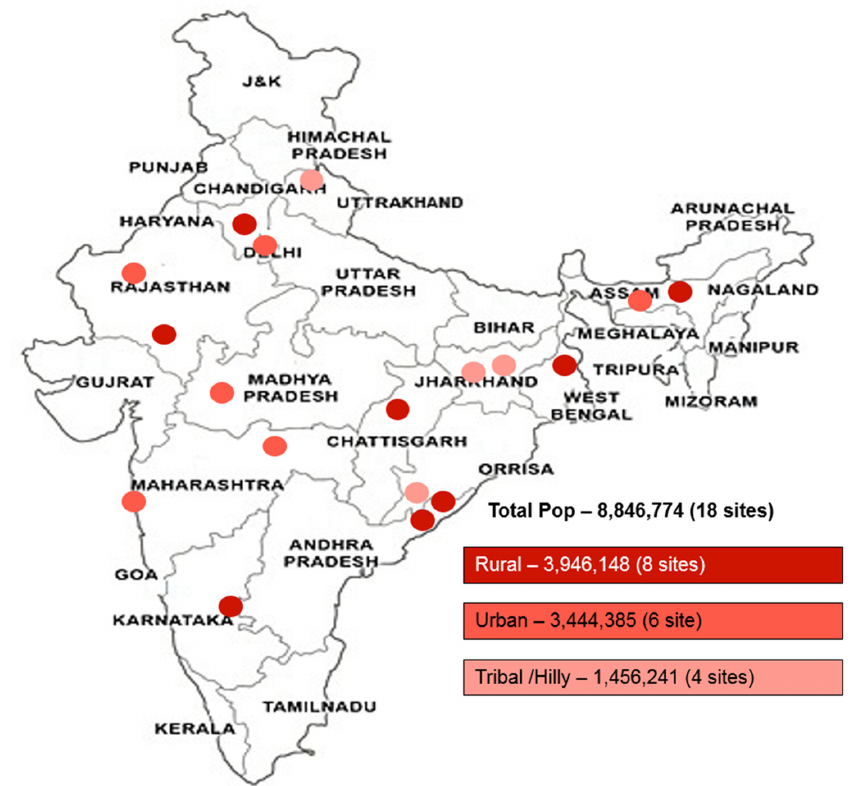
Fig 1. Geographical location of study treatment units and the demographic classification assigned to each project treatment unit site.